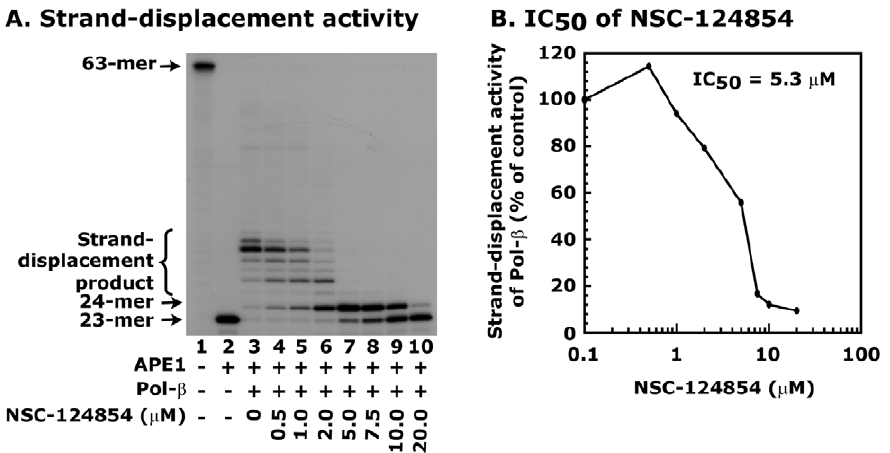
Figure 3. NSC-124854 blocks Pol- b -directed strand-displacement synthesis with a very low IC 50 . To determine the affinity of NSC-124854 for the blockage of Pol- b -directed strand-displacement activity, we determined its IC 50 in a reconstituted assay system as in described in Figure 2. Panel A shows the autoradiogram of the strand-displacement activity. Lane 1 shows 32 P-labeled 63-mer F-DNA, lane 2 shows 23-mer product after APE1 incision, and lane 3 shows strand-displacement activity of Pol- b . Lanes 4–10 shows effect of 0.5–20 m M of NSC-124854 on Pol- b activity. Panel B shows the IC 50 data. NSC-124854 inhibited Pol- b -directed strand-displacement activity in a dose dependent manner with an IC 50 of 5.3 m M. Data are the representative of two independent estimations.